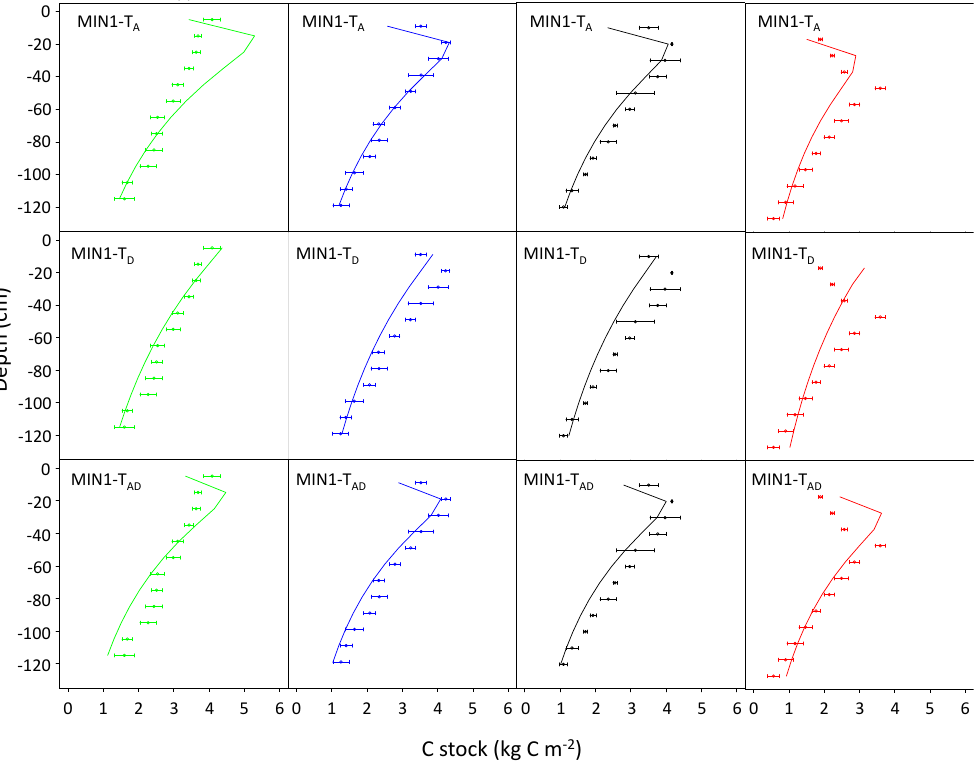
Fig. 4. Total Organic Carbon for the MIN1 transport scheme (first order kinetics) and the three transport schemes ( T A , T D , T AD ) . Measured C stocks are represented by the circles and modelled C stocks by the